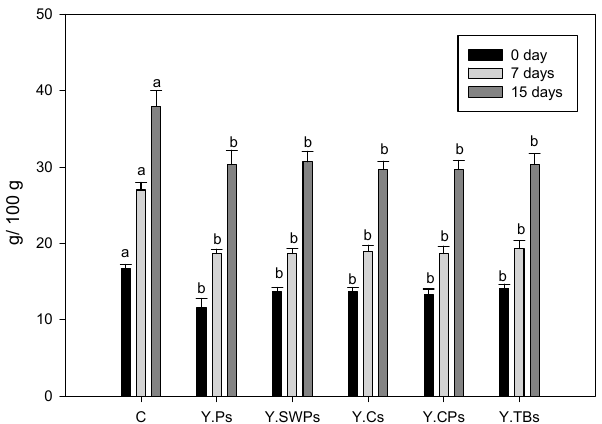
Figure 4. E ff ect of starches addition on whey separation of yogurt. C = Control, Y. Ps = potato starch, Y. SWPs = Sweet potato starch, Y. Cs = corn starch, Y. CPs = Chickpea starch, Y. TBs = Turkish bean starch Yogurt samples with the di ff erent types of starch with the same letter are not significantly di ff erent.